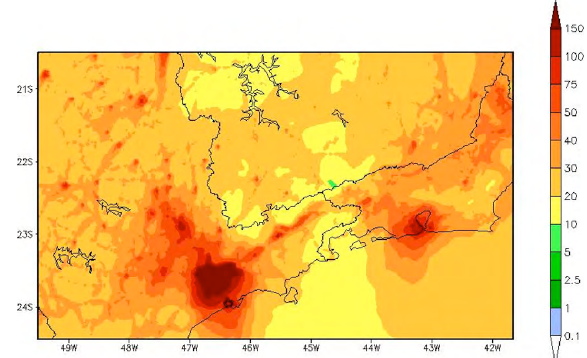
Fig. 8. Monthly average spatial distribution of CO mixing ratio (ppbv) at 09:00 LT from the model.